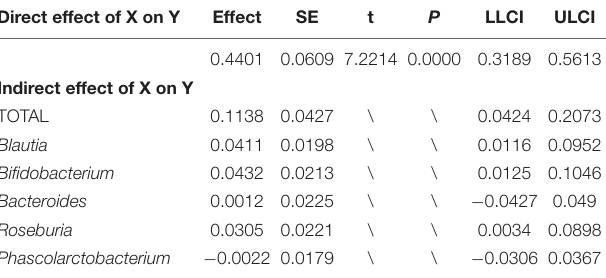
TABLE 2 | The mediating effect of gut